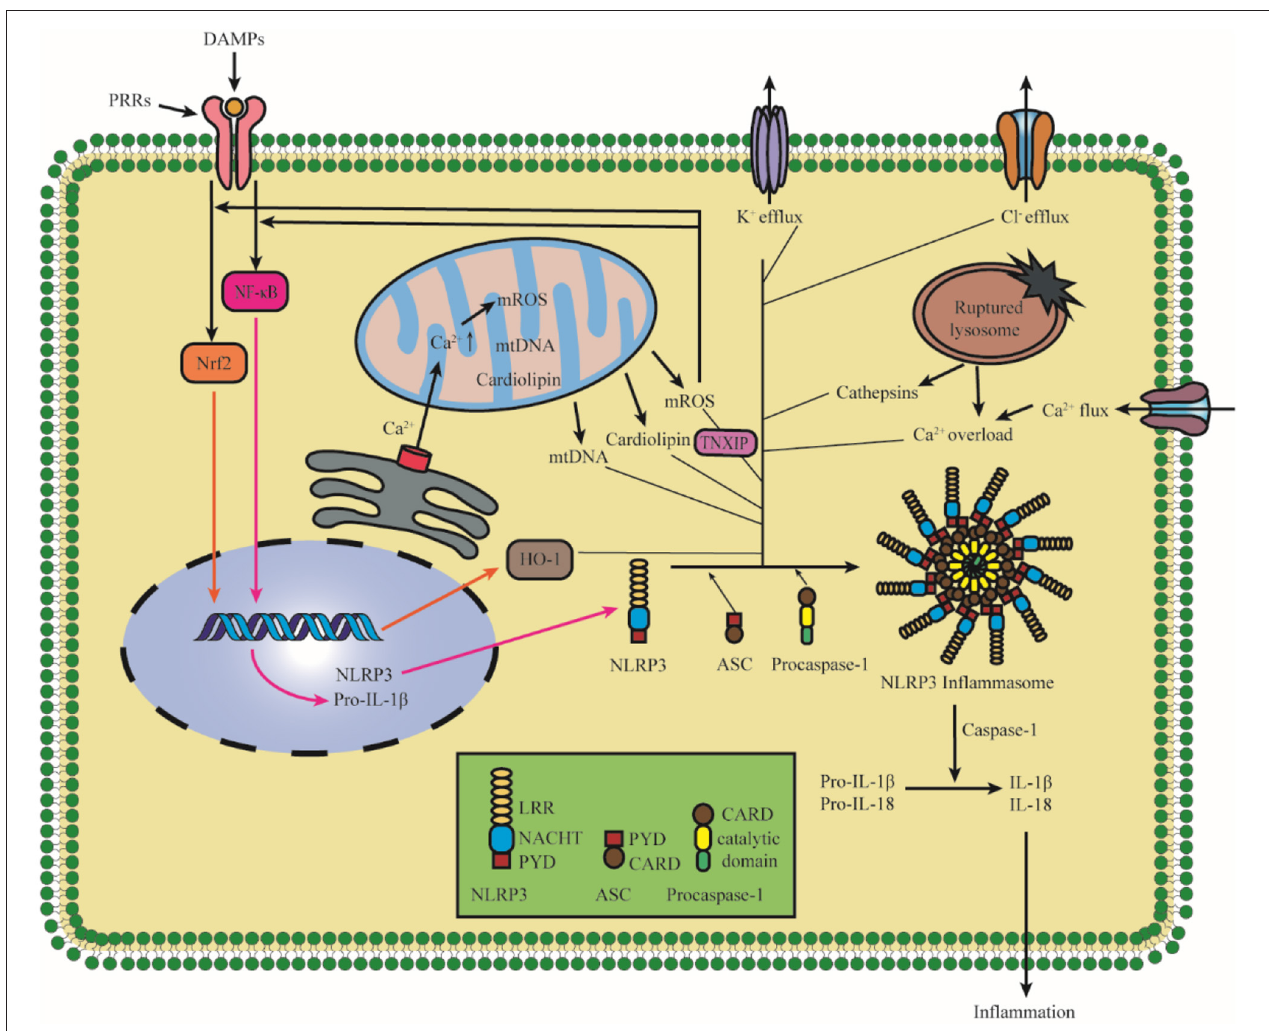
FIGURE 2 | Diagram of NLRP3 inflammasome activation. The priming induces NLRP3 and pro-IL-1 β upregulation in an NF- κ B-dependent manner through translocating to the nucleus. The upstream DAMP and PAMP signaling events lead to the oligomerization of NLRP3 and the assembly of ASC and pro-caspase-1 to form NLRP3 inflammasome. There are mainly three models, which activate the activation of NLRP3 inflammasome: K + efflux, ROS, and lysosomal damage, and specifically it also includes Cl − efflux, Ca 2 + overload, mtDNA, cardiolipin, and the nuclear translocation of Nrf2. The assembly and activation of the NLRP3 inflammasome lead to the cleavage of Caspase-1, which promotes the maturation and cleaves proinflammatory cytokines IL-1 β and IL-18. NLRP3, pyrin domain-containing protein 3; NF- κ B, nuclear factor-k-gene binding; HO-1, Hemeoxygenase-1; TNXIP, thioredoxin interacting protein; PRR, pattern recognition receptor; DAMPs, damage/danger-associated molecular patterns; Nrf2, NF-E2-related factor 2; ROS, reactive oxygen species; mtDNA, mitochondrial